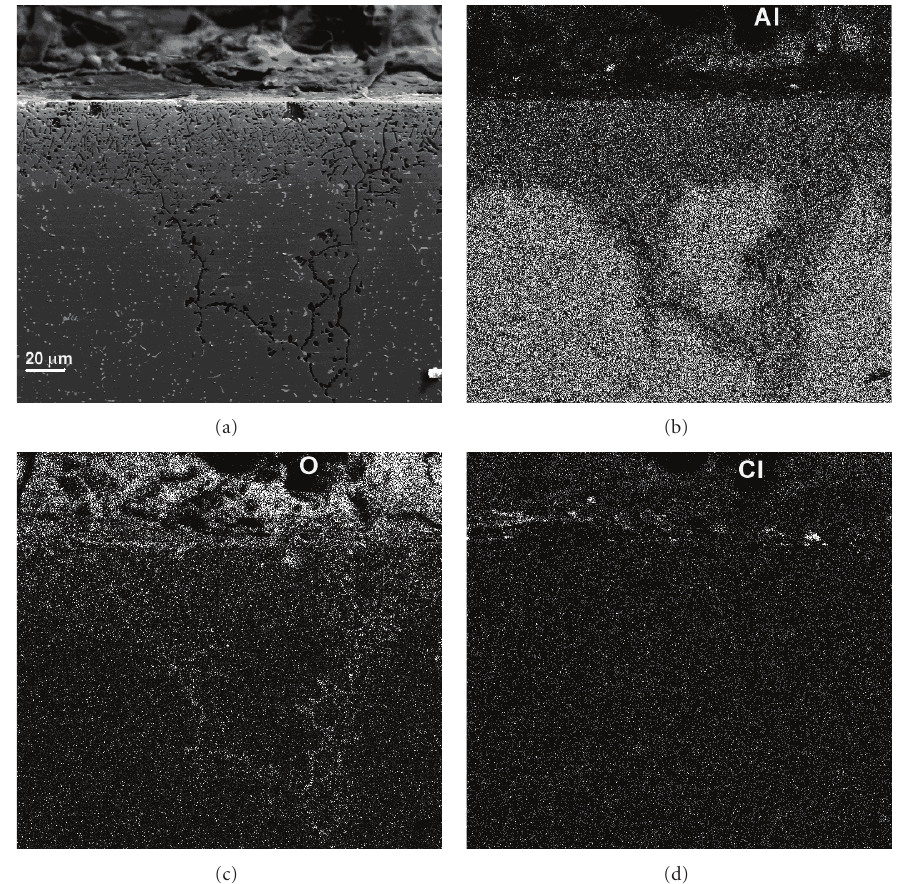
Figure 8: Micrograph of Fe40Al + 3Ag alloy corroded in NaCl-KCl at 670 ◦ C together with the X-ray mappings of Al, O, and Cl.